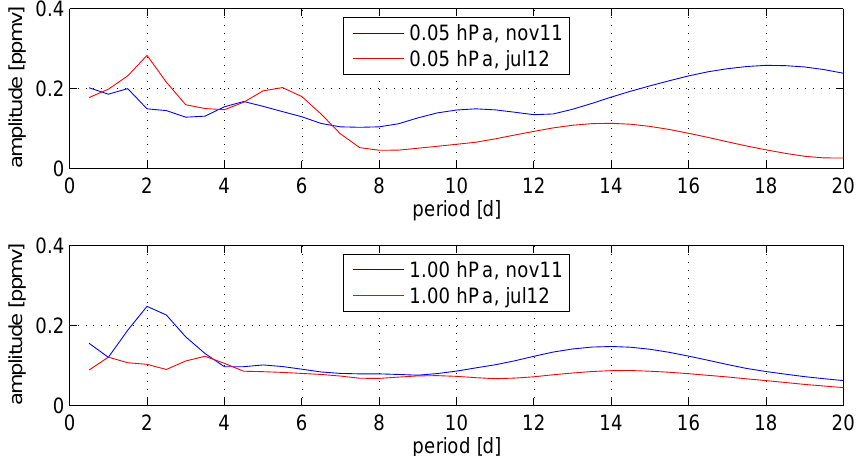
Figure 3. Mean amplitude of different periods obtained by filtering the water vapour time series on two altitude levels (top: 0.05hPa, bottom: 1hPa) for 1 to 30 November 2011 (blue) and 27 June to 24 July 2012